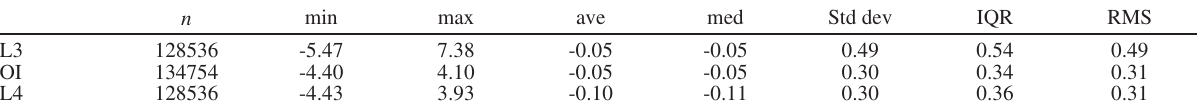
Table 1. – Statistics of the differences between the 9-day, 0.25-degree SMOS products and the Argo surface. n